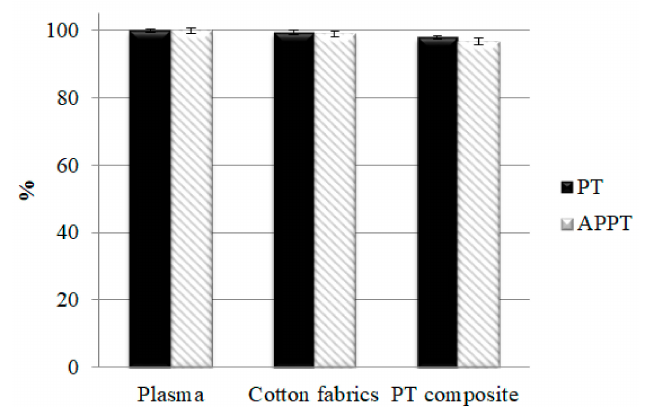
Figure 15. PT and APTT of polyacrylate/Tencel ® nonwoven composite.